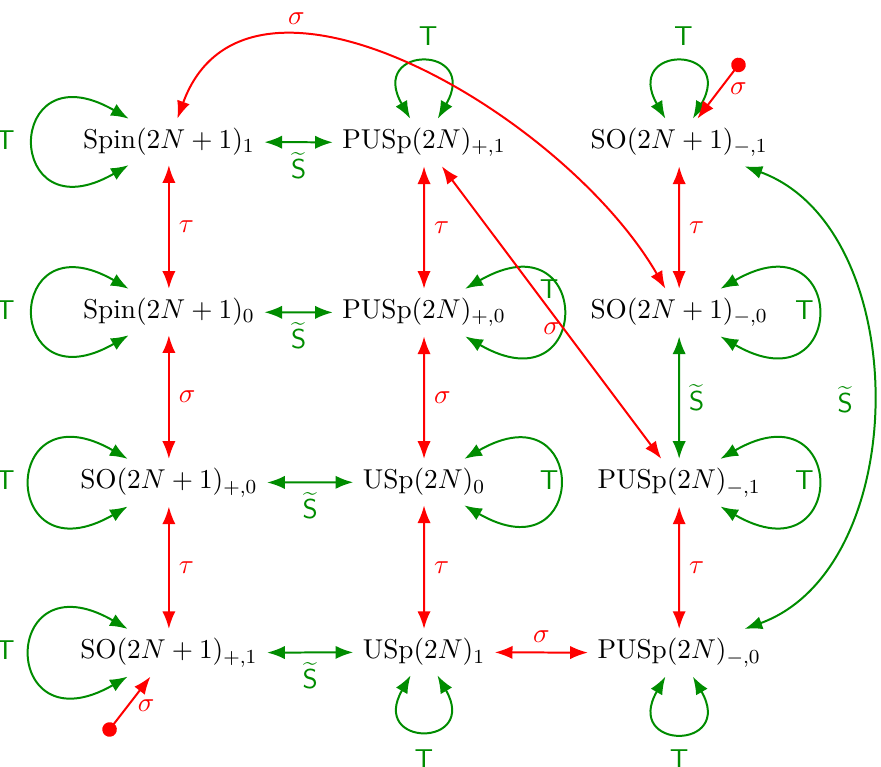
Figure 10 . Web of transformations for theories with gauge algebra usp (2 N ) for N even.